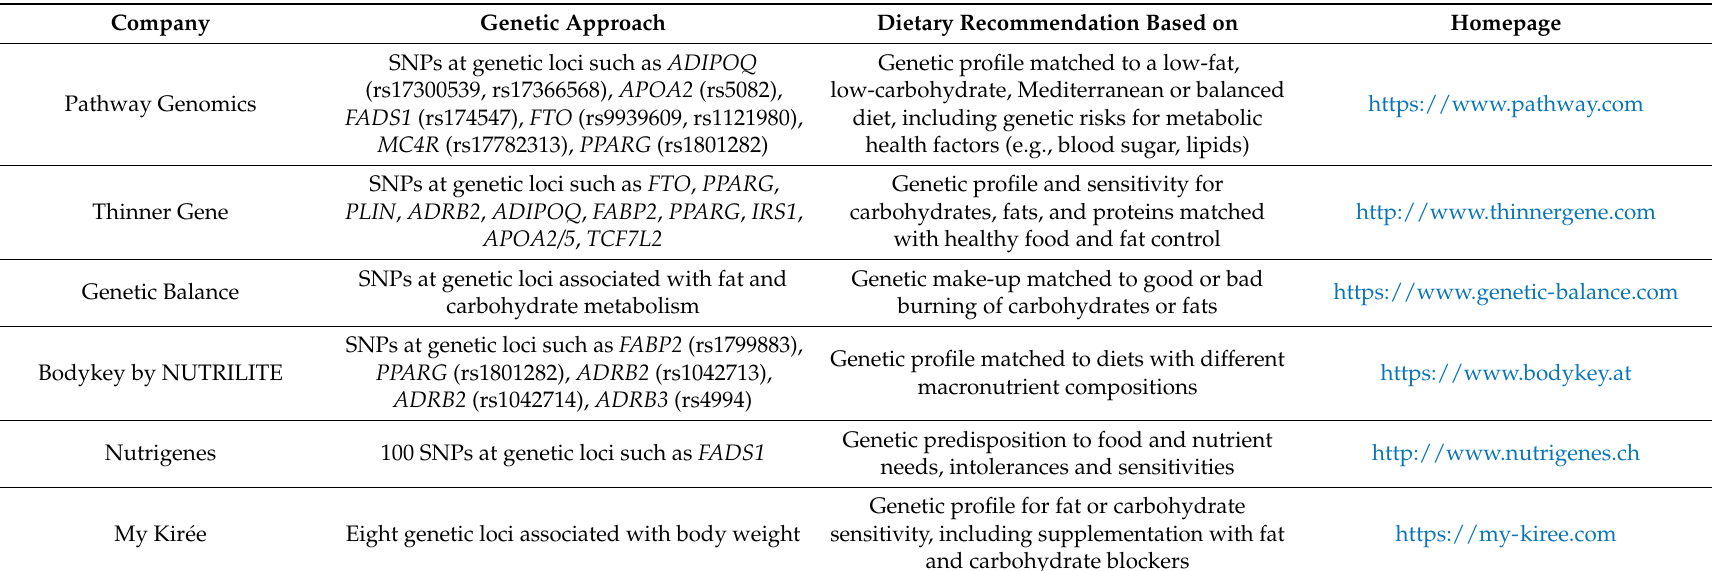
Table 2. Examples of companies offering gene-based dietary recommendations for weight